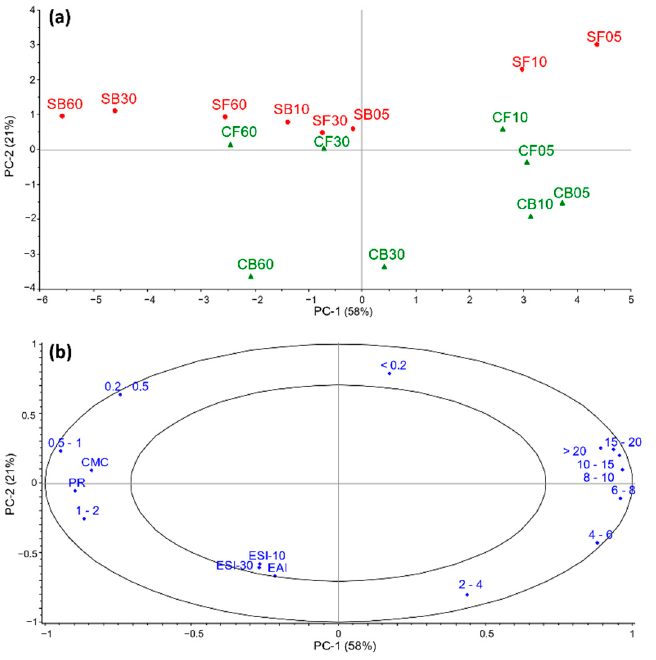
Figure 1. Principal component analysis score plot ( a ) shows similarities and differences between salmon (S) and cod (C) backbone hydrolysates made with FoodPro PNL (F) and Bromelain (B) for 5, 10, 30 and 60 min. The correlation loading plot ( b ) illustrates associations between molecular weight distribution (kDa), protein recovery (PR), critical micelle concentration (CMC), emulsion stability after 10 min (ESI-10), emulsion stability after 30 min (ESI-30), and emulsion activity index (EAI). The two ellipses represent 50% and 100% of explained variance.